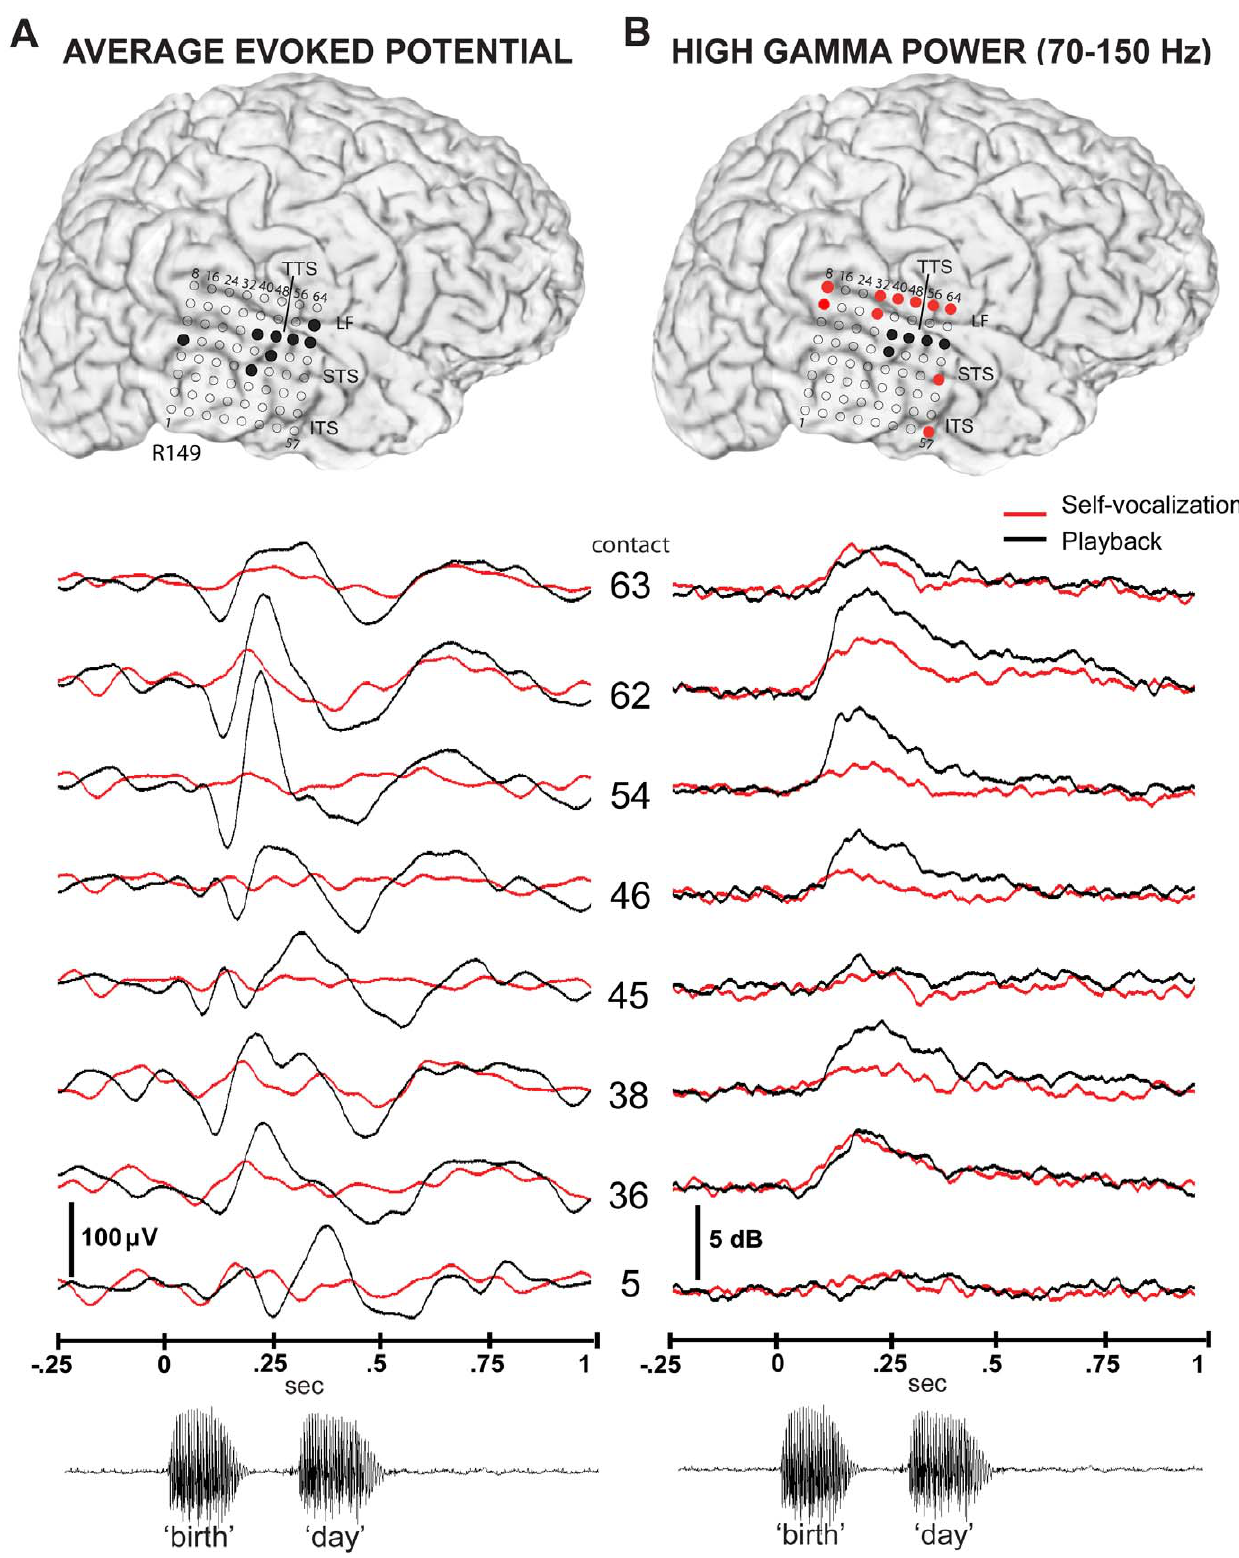
Figure 4. AEP and high gamma power responses in subject 149 during self-vocalization and playback. (A) Right hemisphere surface rendered MRI showing recording site locations and major sulci. Black circles denote contacts where the AEP during the SV condition was significantly attenuated compared to the PB condition (p , .01, 0–500 msec post-voice onset). Tracings below show superimposed AEPs during SV (red line) and PB (black line) recorded from the eight contacts marked with black circles. Contacts are labeled numerically. Onset of vocalizations for both the SV and PB conditions is delineated as time 0. Although responses from all of the displayed channels are attenuated during SV, the magnitude of